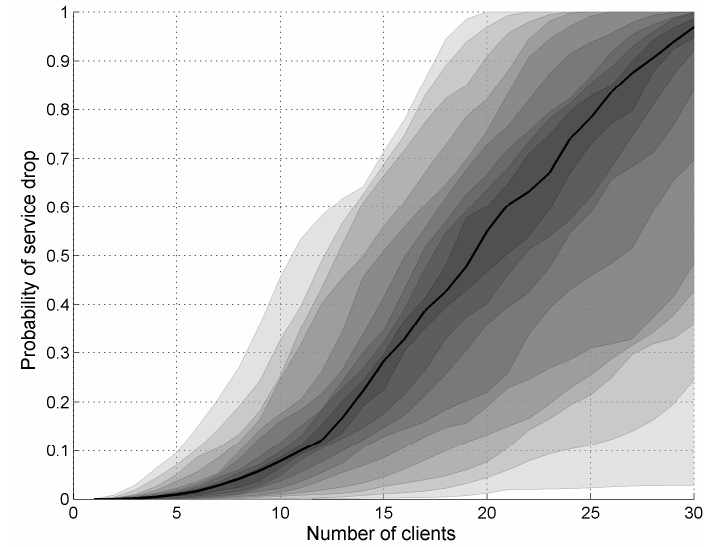
Figure 11. Probability of service drop with respect to the number of clients: Median value and deciles are shown.